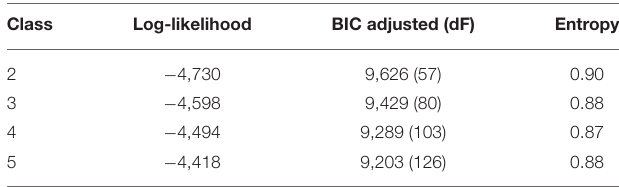
TABLE 5 | Model fit indices for a different amount of classes for latent profile analysis ( N =